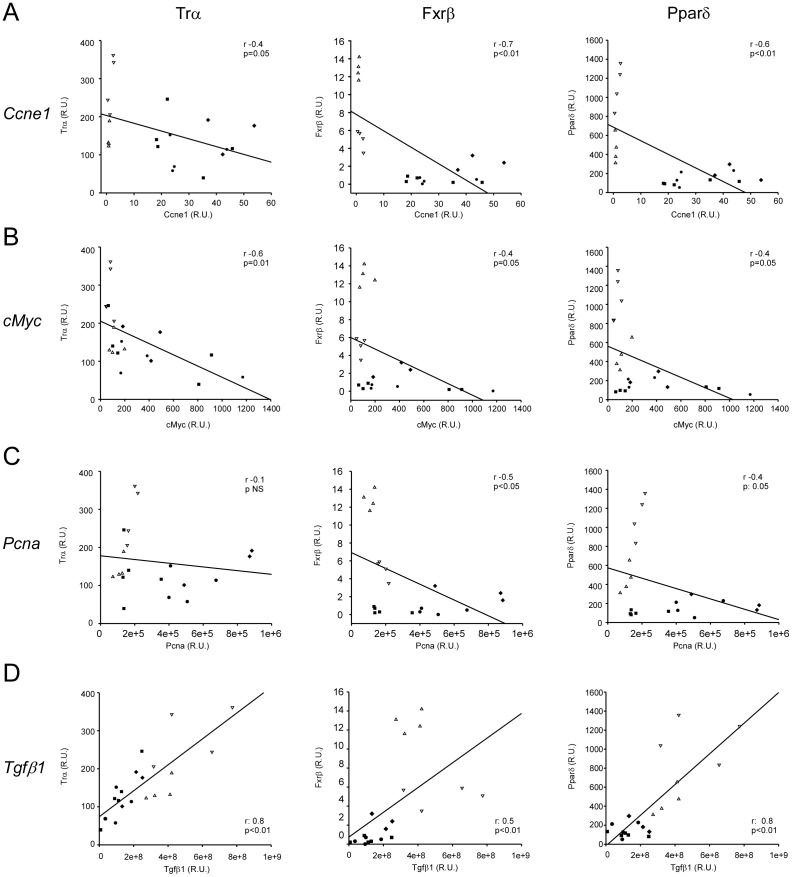
Markers of hepatocyte proliferation and growth termination correlate with the top three NRs at RF analysis.
Trα, Fxrβ, and Pparβ/δ mRNA expression levels correlate negatively with Ccne1 (A) and cMyc (B), and positively with Tgfβ1 (D); Fxrβ and Pparβ/δ, but not Trα, also correlate negatively with Pcna expression levels (C) (0.4>Pearson's correlation coefficient<−0.4; p<0.05). Legend: (white) quiescent; (black) proliferating; (▴) Sham; (▪) 0.5 days; (•) 1 day; (♦) 3 days; (▾) 7 days.